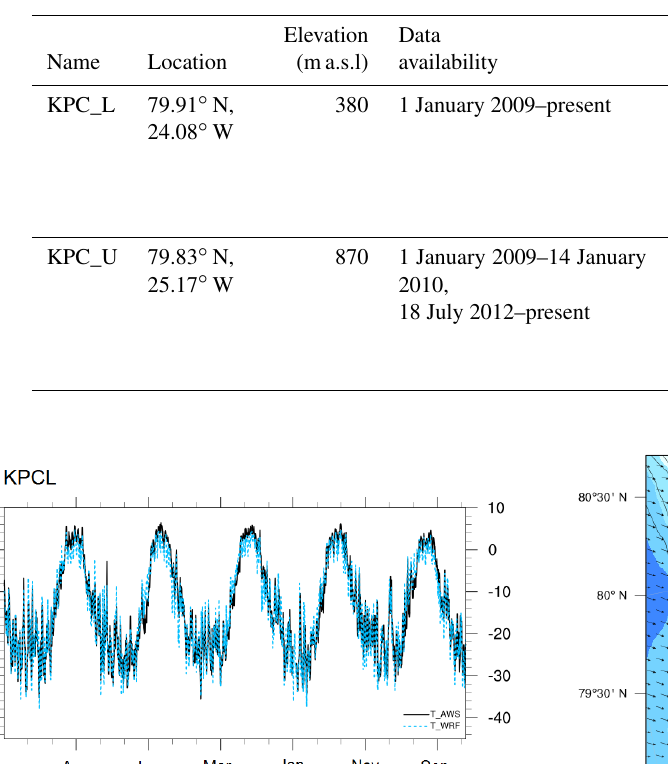
Table 1. The location, elevation, and data availability of the two AWSs used for model evaluation. We evaluate the model output with six variables from the AWSs. Data were unavailable at KPC_L between 15 January 2010 and 17 July 2012 due to retrieval problems. T is air temperature, Q is specific humidity, and W S and W D are wind speed and direction. Observations are taken at approximately 2m above the surface, but this does vary with accumulation and ablation (see Sect. 2.2). Sensor error estimates come from the sensor manufacturers. See van As and Fausto (2011) for more information on sensors and observations.